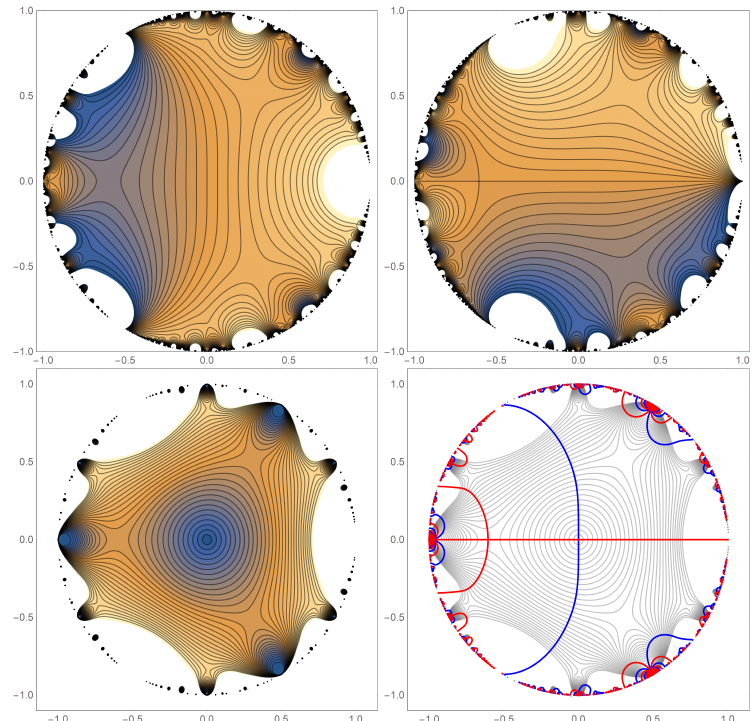
Figure 6. The case of L ( C ( 3 ) ; z ) . The top row consists of plots of the real part ( left ) and imaginary part ( right ) of f 16 ( z ) . The bottom left graph is of | f 16 ( z ) | exactly as in Figure 2. The bottom right shows | f 16 ( z ) | superimposed with the zero curves of the real (blue) and imaginary (red) parts of f 16 ( z ) . Of note is that the real and imaginary parts do not carry the symmetry nor polishness of the